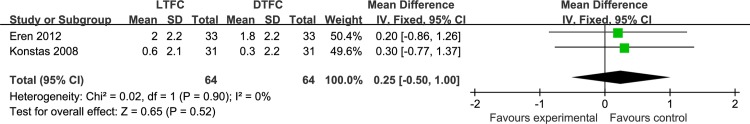
Forest plot of the IOP fluctuation, comparison of LTFC and DTFC.